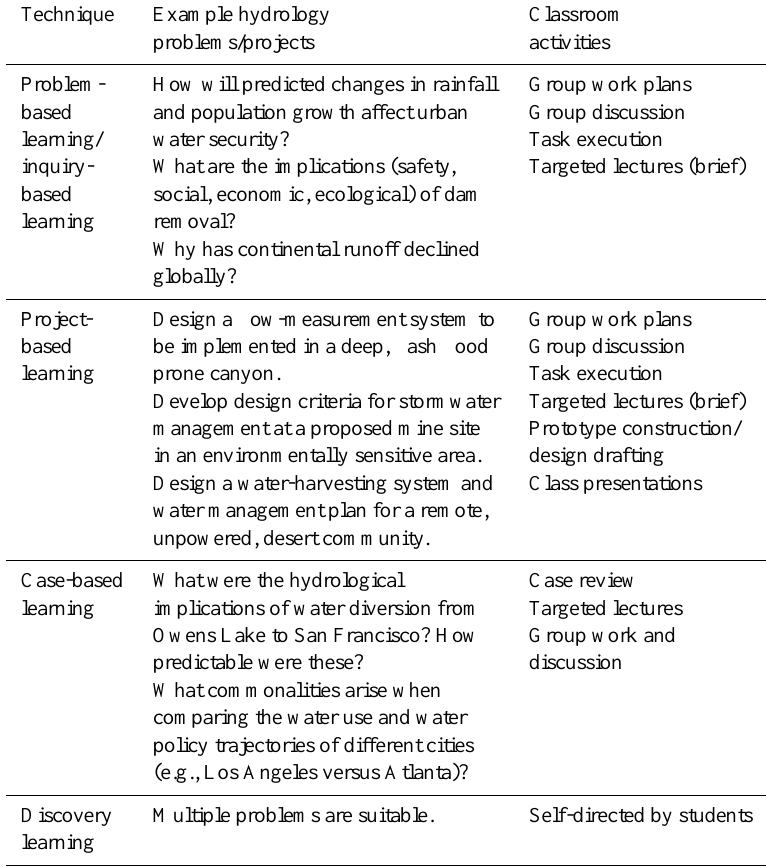
Table 1. Examples of inductive teaching and learning approaches for hydrology